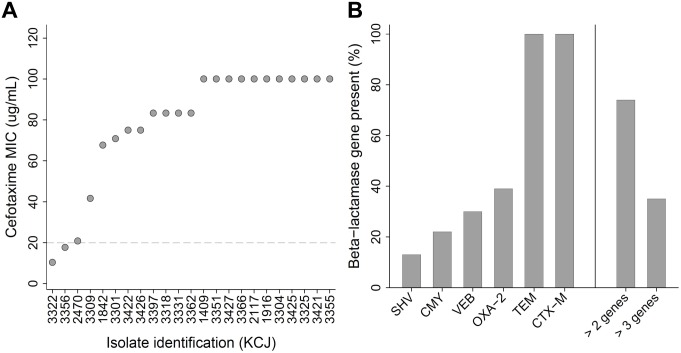
MIC of cefotaxime and multiplex PCR for ESBL genes.(A) The results of the subset of cefotaxime resistant bacterial isolates subjected to minimum inhibitory concentration MIC testing with cefotaxime. (B) The percentages (%) of isolates that had the presence of nine different β-lactamase genes determined by polymerase chain reaction PCR; only six genes were identified, with isolates frequently carrying more than one β-lactamase gene.